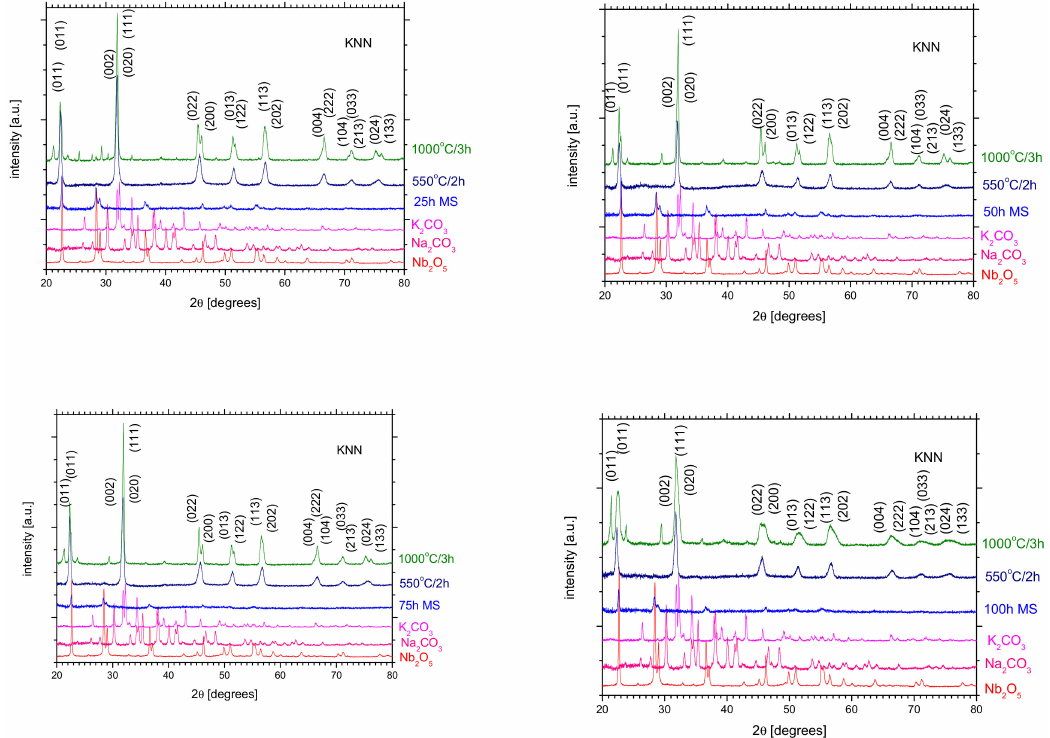
Figure 1. XRD di ff raction patterns of powders at di ff erent stages of preparation. The Rietveld method allowed the determination the unit cell parameters and volume (V) of all investigated ceramics (Table